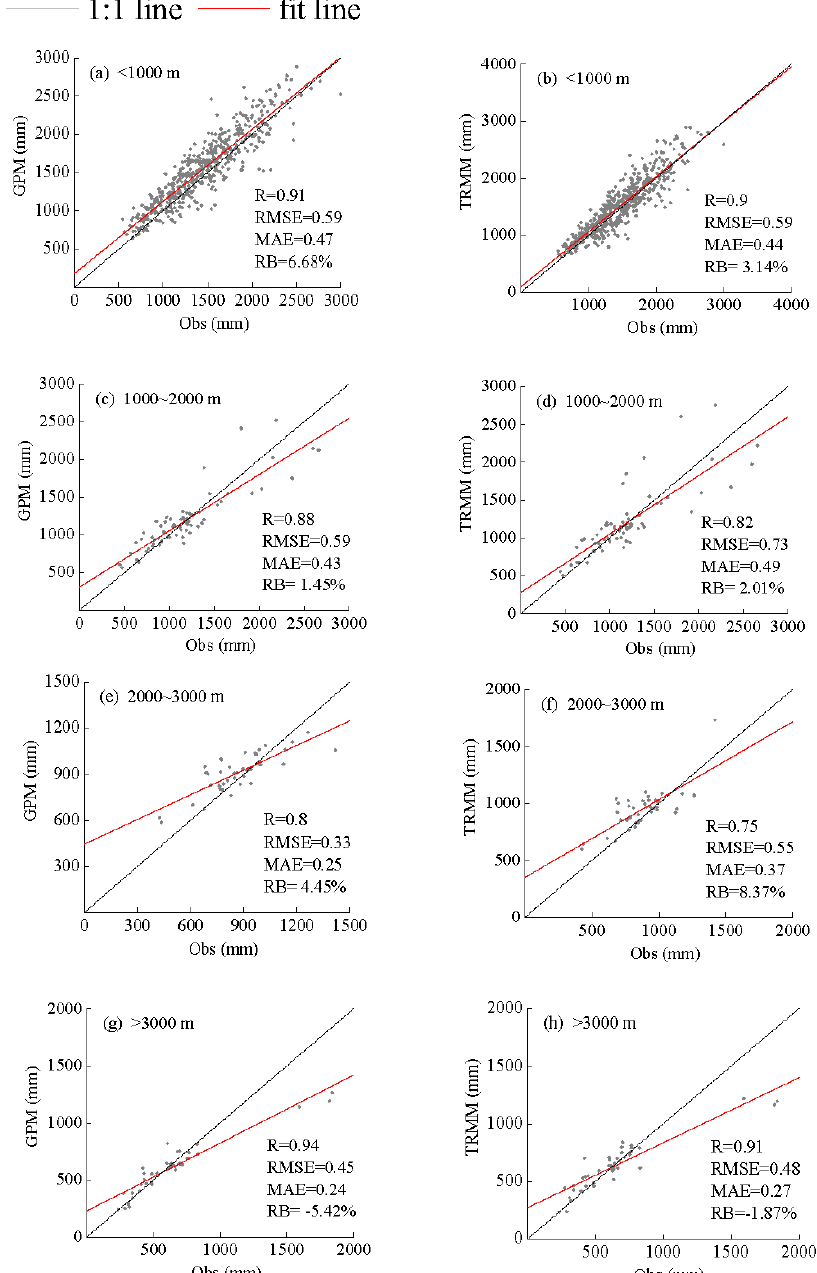
Figure 7. Scatterplots of annual precipitation between rain gauge stations and two SPPs at different altitudes. ( a , b ): < 1000 m; ( c , d ): 1000~2000 m; ( e , f ): 2000~3000 m; ( g , h ): > 3000 m)